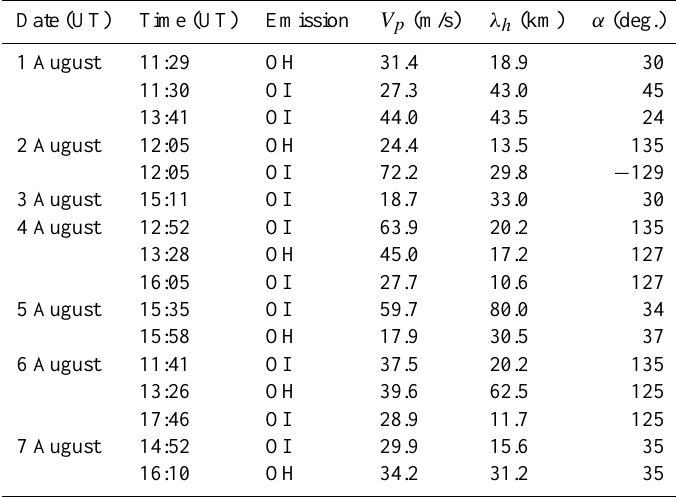
Table 1. Summary of wave events detected at Nishino-Omote for eight nights. V p and λ h indicate horizontal phase velocity and horizontal wavelength of gravity wave, respectively. α indicates the azimuth (clockwise from geographic north) of gravity wave propagation. Local time is UT+9h.